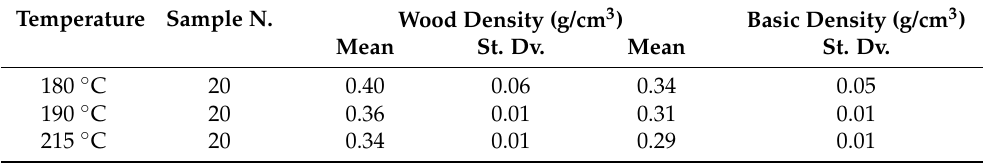
Table 1. Wood density and basic density of heat-treated ayous wood. Temperature Sample